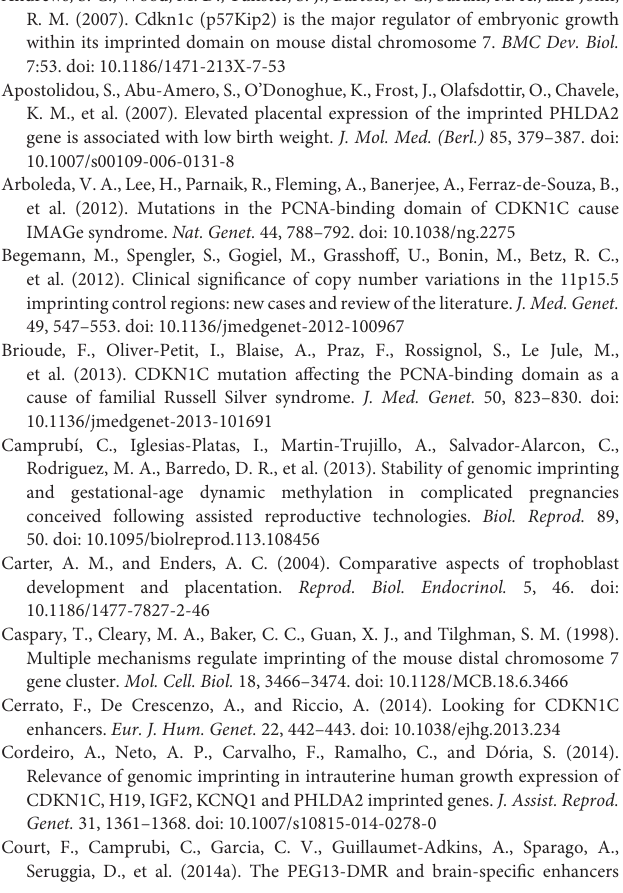
TABLE S3 | A summary of non-significant variables that are not associated with changes in CDKN1C expression